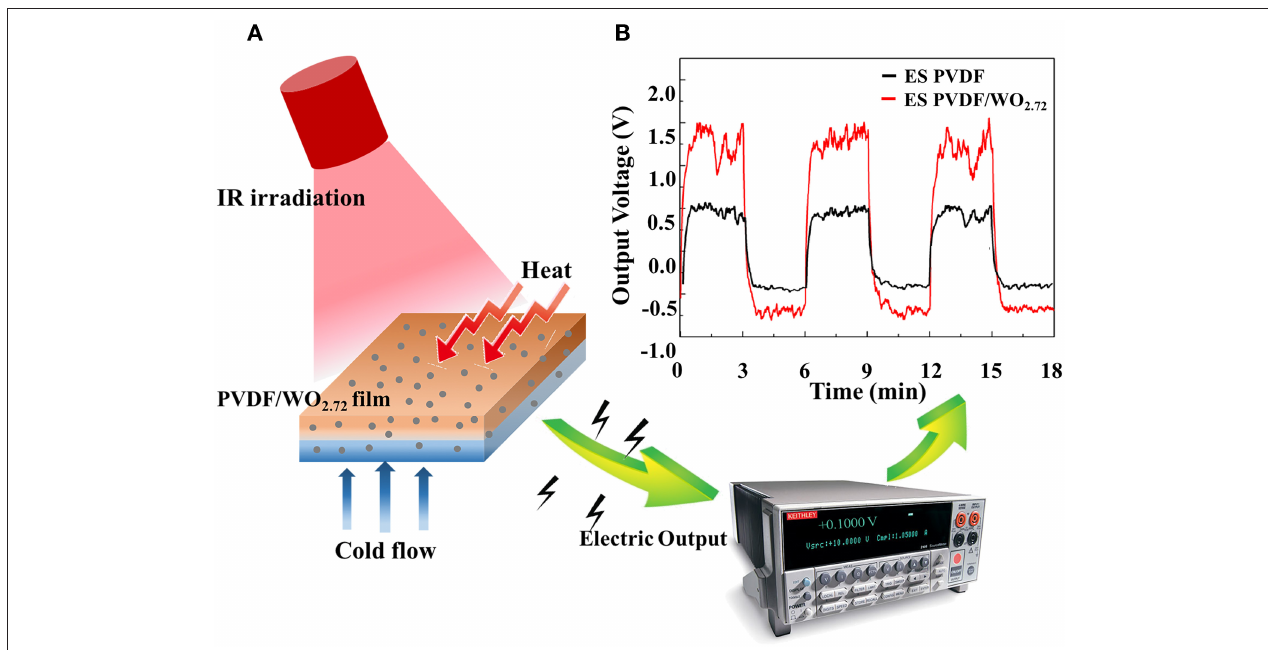
FIGURE 3 | (A) Schematic illustrations of the pyroelectric measurement and (B) pyroelectric ability of electrospun PVDF and PVDF/WO 2.72 in response to the corresponding rate of change in temperature ( Wu et al., 2017a).